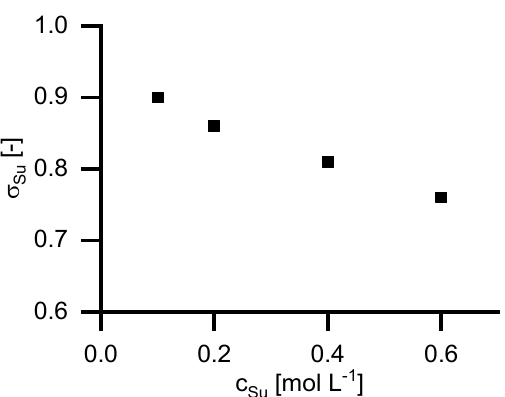
Figure 8. Reflection coefficient of disodium succinate in aqueous solution at 40 °C in relation to the feed concentration of succinate.